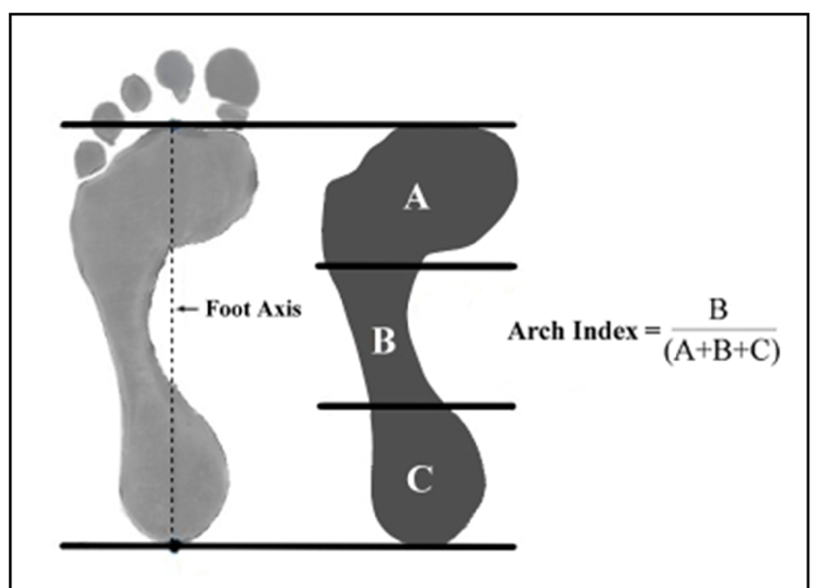
Figure 1. Calculation of the Arch Index.